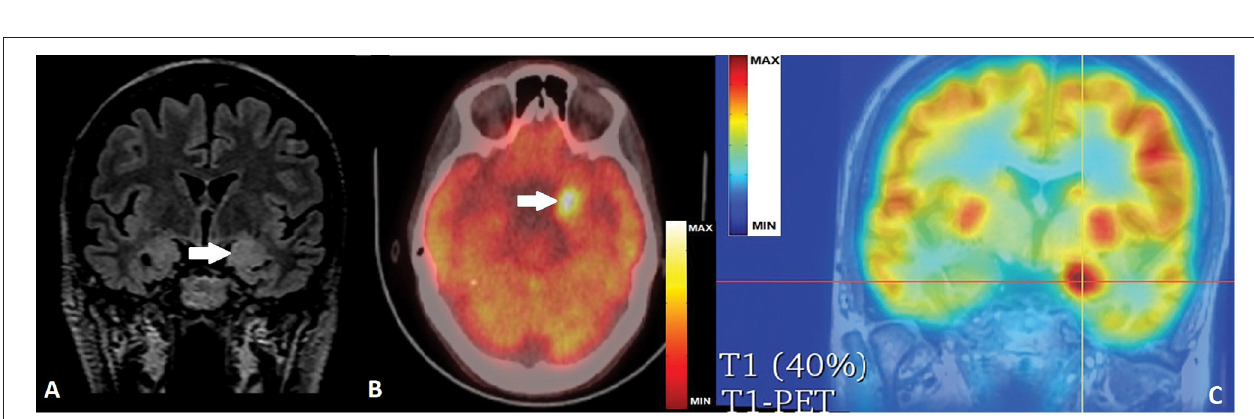
FIGURE 1 | (A) EEG in wakefulness with left temporal sharp- and spike-wave (SW) complexes with maximum and phase reversal on T1-T3 (red arrow). Individual seizures occurring at fairly regular interval and high frequency (blue arrow). (B) Ictal EEG epoch from the clinical seizure onset (red arrow) demonstrating the evolution of the left temporal ictal discharge consisting of rhythmic SW with an increasing amplitude and a spread mostly to the central region.